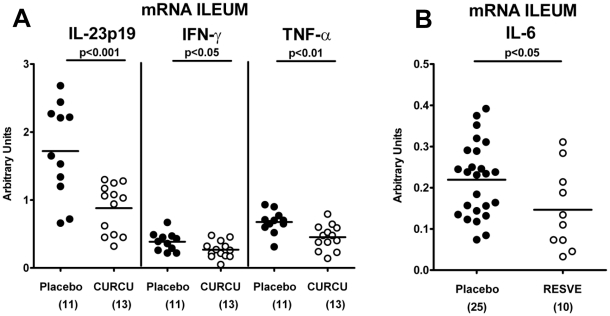
m-RNA Expression of pro-inflammatory cytokines in ilea of mice 8 days after T. gondii infection and treatment with (A) Curcumin or (B) Resveratrol from d-2 until d8 p.i. compared to Placebo controls.RT-PCR results of IL-23p19, IFN-γ and TNF-α (A) and IL-6 (B) expression from individual mice are expressed as fold changes relative to HPRT mRNA expression (arbitrary units). Numbers of analyzed animals are given in parentheses. Mean values and significance levels as indicated were determined by the Student's t test. Data are pooled from at least three independent experiments.